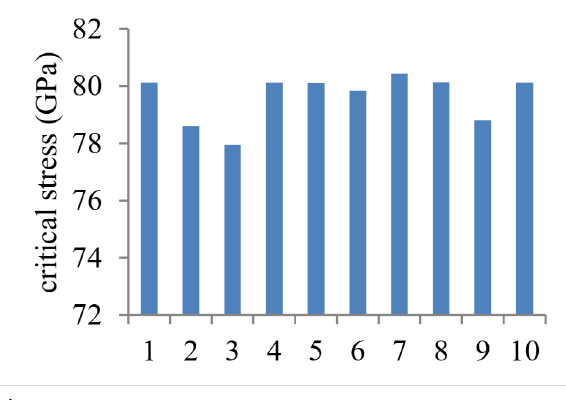
Figure 6: The variances of the critical stress for 0.01% defected zigzag BNNS at different temperature.